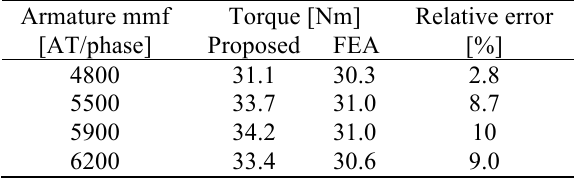
Table 3: Relative errors between proposed method and